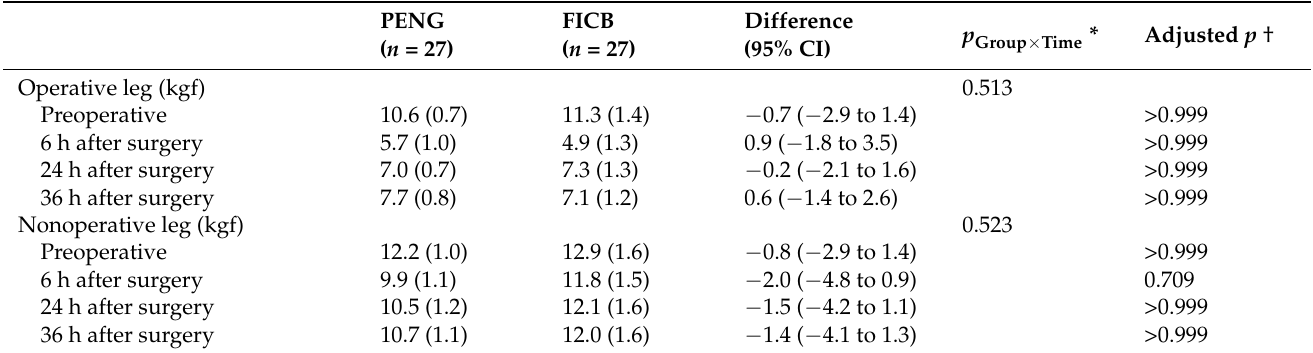
Table 3. Quadriceps muscle strength measurements.